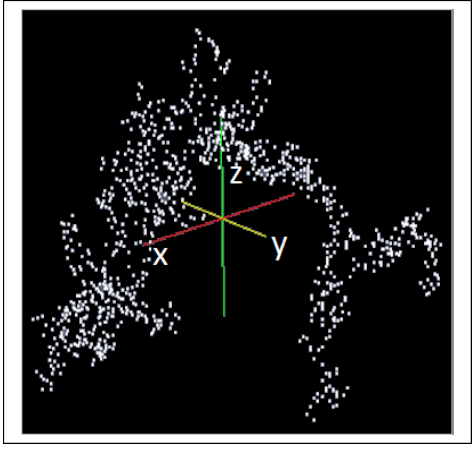
Figure 3. Structure of the model gel fragment (cluster of 1,000 particles)